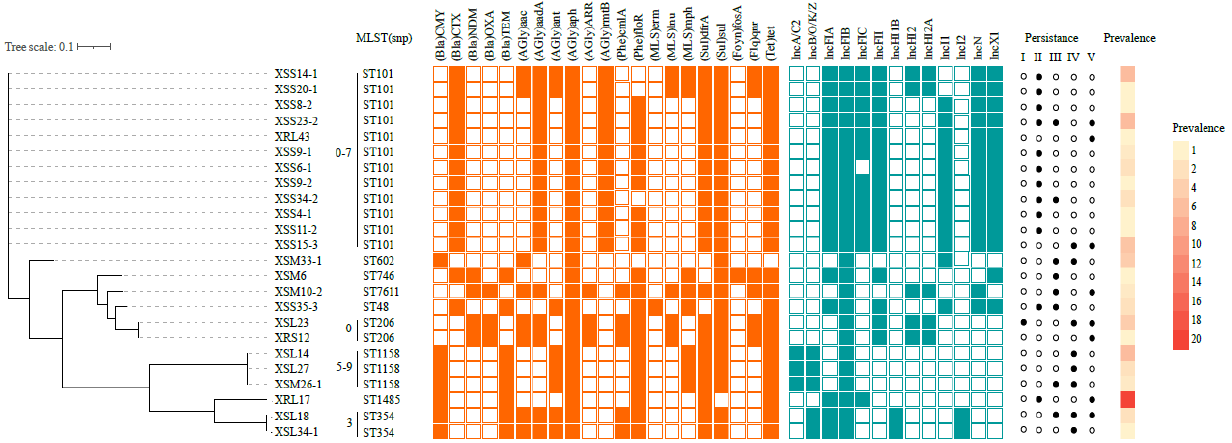
Figure 1. Prevalence, persistence, phylogenetic and genomic characterization analysis of the 24 ceftiofur-resistant E. coli isolates we isolated for this study. The orange and green squares represent positivity for ARGs and plasmid Inc types, respectively. Roman numerals represent the persistence of ceftiofur-resistant E. coli across five stages of chicken breeding: I, egg; II, GP period; III, EL period; IV, PL period; V, LL period. Filled circles represent ceftiofur-resistant E. coli and the heatmap indicates the numbers of ceftiofur ‐ resistant E. coli shared between ERIC ‐ PCR patterns.